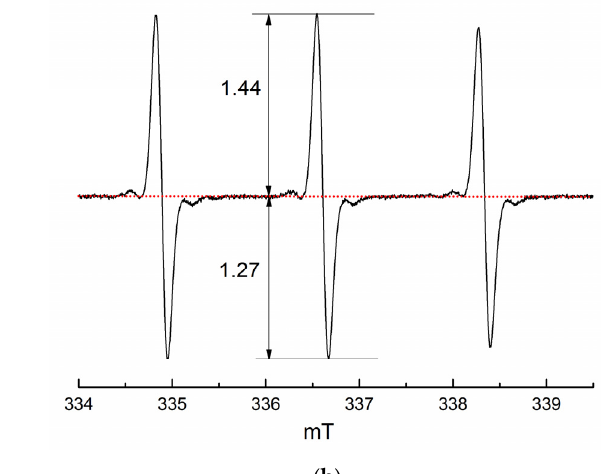
Polymers 2021 , 13 , x FOR PEER REVIEW Figure A4. EPR spectra of TEMPO radical in water (0.3 mM) ( a ) and 10% PNIPAM solution (0.5 mM) ( b ) at 298 K. Arrows show amplitude value of spectra above and below the baseline. Red dot line shows baseline.